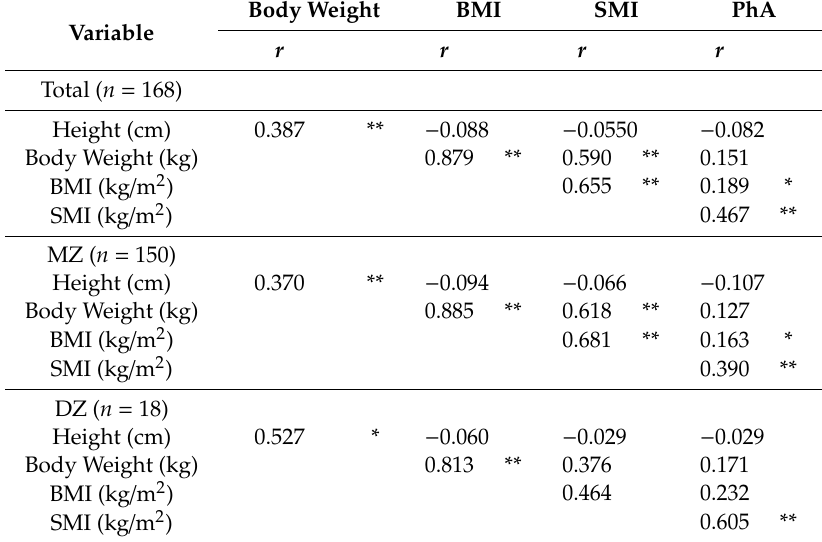
Table 2. Pearson correlations between anthropometric measurements and phase angle in monozygotic and dizygotic